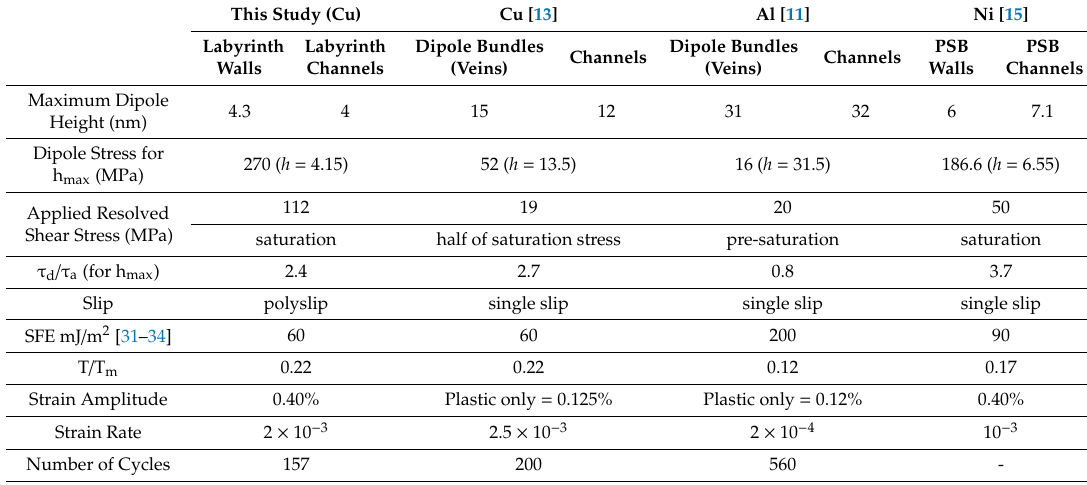
Table 1. Dipole heights and stress calculations (Equation (1) for [11,13,15] and Equation (3) for this study) based on observed maximum “ h ”